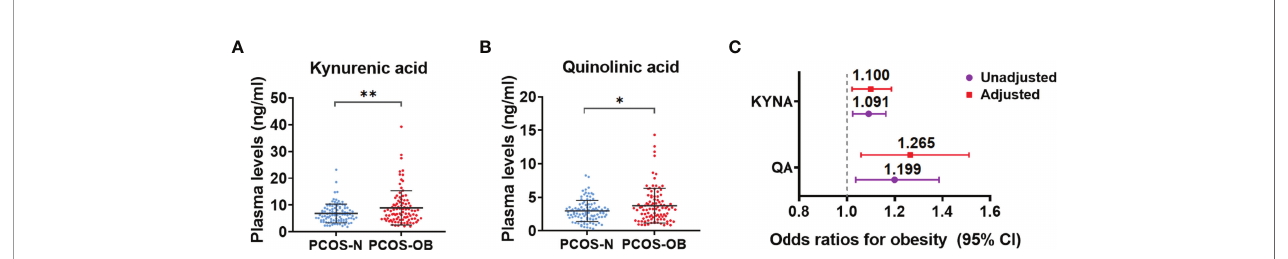
FIGURE 4 | Determination of metabolites in tryptophan-kynurenine pathway associated with the obesity risk in women with PCOS. (A, B) The plasma level changes of kynurenic acid (A) and quinolinic acid (B) in overweight/obese PCOS patients compared with normal weight PCOS women. ** p < 0.01; * p < 0.05. (C) The odds ratios (95% CIs) of obesity in women with PCOS per 1 SD increase in plasma abundance of KYNA, kynurenic acid and QA, quinolinic acid before and after adjusting for baseline age, LH, androstenedione